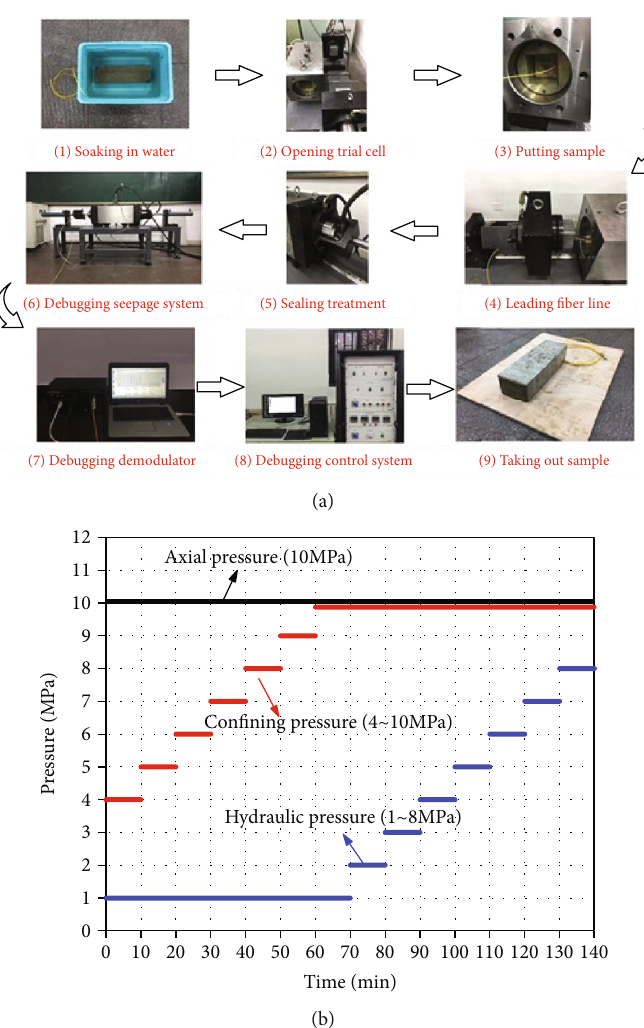
Figure 6: Experimental methods: (a) test procedures and (b) loading scheme.